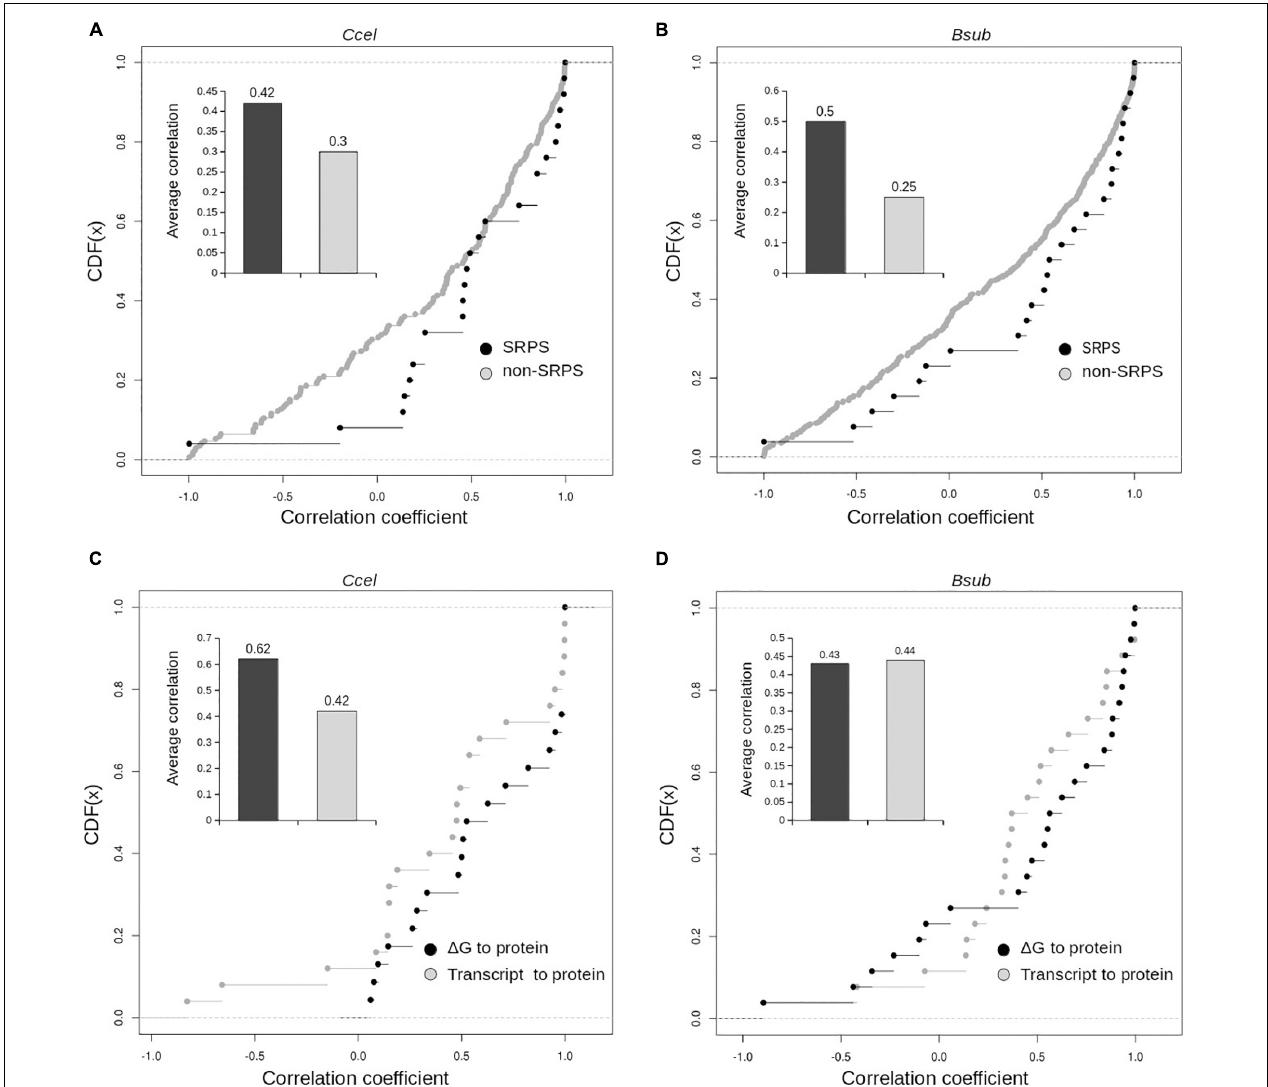
FIGURE 6 | Distribution of the correlation coefficients of the (cid:49) G -based ratios and the experimentally measured protein correlations for the selective RNA processing and stabilization (SRPS) and non-SRPS operons. Cumulative distribution of the correlation coefficients between the (cid:49) G -based ratio and the protein abundance ratio for the SRPS and non-SRPS operons. Correlation coefficients plotted over the cumulative distribution function (CDF) for the SRPS and non-SRPS operons in Ccel (A) and Bsub (B) . Inset shows the average correlation values for the two categories of the operon. Correlation coefficients of the (cid:49) G -based ratio to protein and of the transcript to protein were compared in the Ccel (C) and Bsub (D) genomes for SRPS operons ( via cumulative distribution function, CDF). Inset : average correlation values for the two categories of